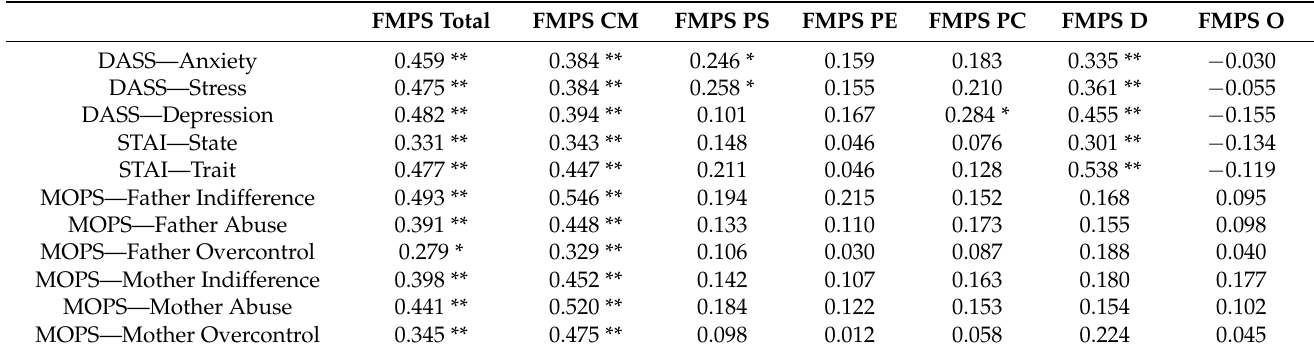
Table 2. Correlations among FMPS subscales and all other measurements in a sample of n =